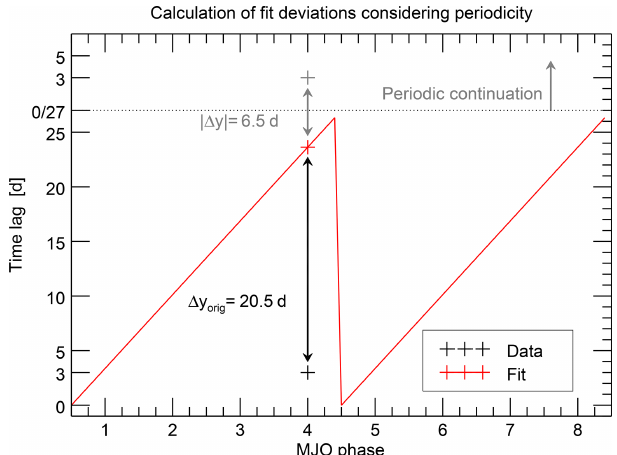
Figure A1. Illustration of the calculation of deviations between the data points and the fitted values. For reasons of clarity, only one data point has been included (black cross). With the conventional approach, the deviation (cid:49)y orig is simply the difference between the observed and the fitted value (red cross), which is 20.5 days in this example. However, the fitted relationship is not only periodic in the direction of the abscissa, but also in the direction of the ordinate, since possible time lags repeat themselves with a period of 27 days. The observed data can therefore be virtually periodically continued and it becomes obvious that the relevant deviation (cid:49)y is that be- tween the fitted data point and the newly introduced virtual data point (gray cross), which has a value of (cid:49)y = − 6 . 5 days ( = 20 . 5– 27 days) in this